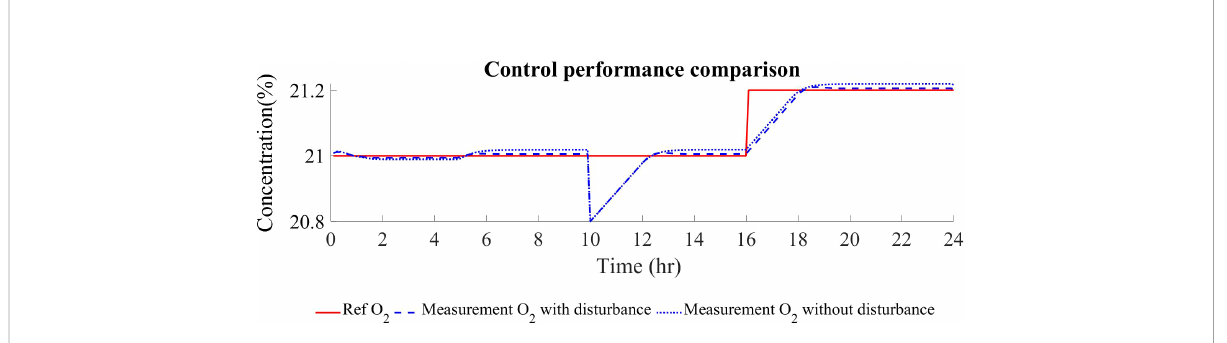
FIGURE 9 Comparison of the controller performance in terms of reference tracking between controllers including or not disturbance rejection in the internal SSTO and MPC